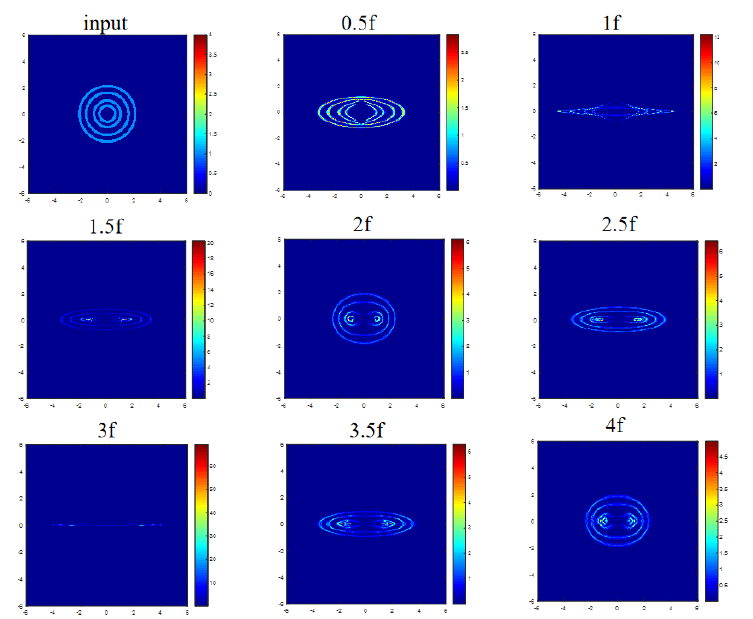
Figure 7. Simulated intensity pattern at 0.5 f , 1 f , 1.5 f , 2 f , 2.5 f , 3 f , 3.5 f , and 4 f in the 4 f optical system to display the progress of circle-Cassinian